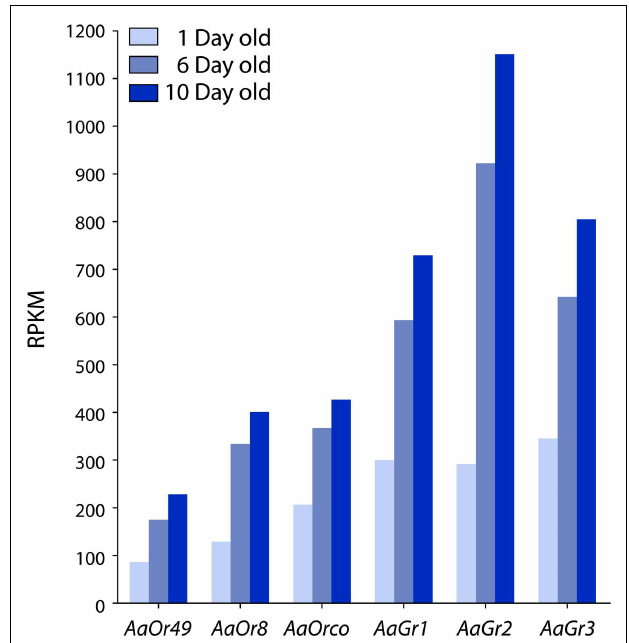
FIGURE 5 |Temporal expression of AaOr and AaGr genes in the maxillary palps of female Aedes aegypti defined by RNA-seq. All genes were highly expressed throughout adulthood.The largest increase in expression occurs between 1 and 6days old animals, and is followed by a plateau in 10days old